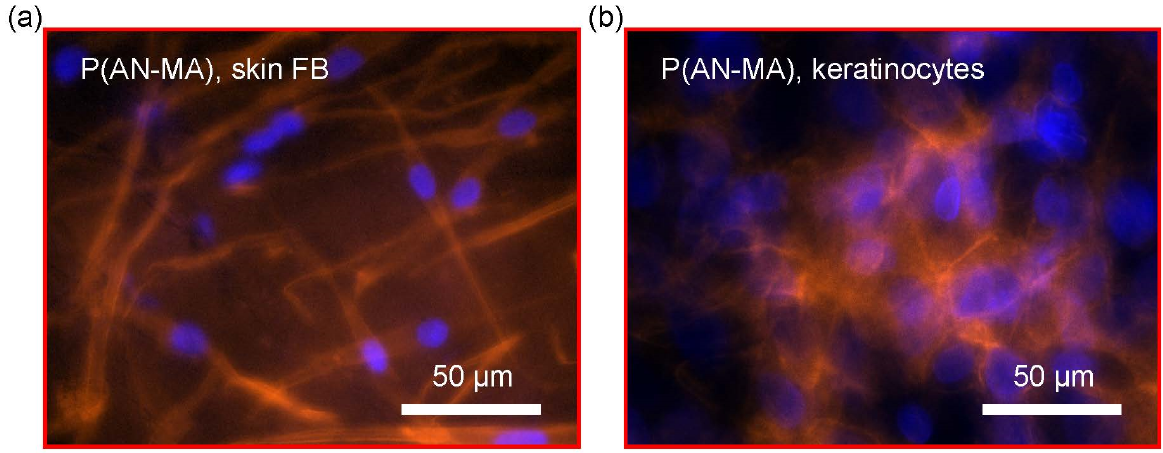
Figure 6. Cell distribution and morphology on electrospun nanofiber mats. Cells were cultured for 7 days on P(AN-MA) nanofiber mats and stained with Phalloidin-TRITC and Hoechst: ( a ) Primary skin FBs and ( b ) primary keratinocytes.